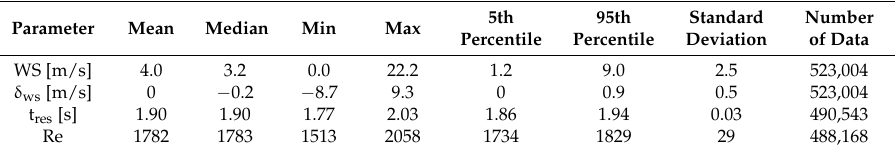
Figure 8. Frequency distributions of wind speed ( A ), wind speed variability ( B ), sample residence time calculated for the gas air-intake ( C ) and Re calculated for the aerosol air-intake ( D ). Table 1. Statistical parameters of wind speed (WS), wind variability ( δ ws ), sample residence time (t res ) calculated for the gas air-intake and Reynolds number (Re) calculated for the aerosol air-intake over the investigation period.